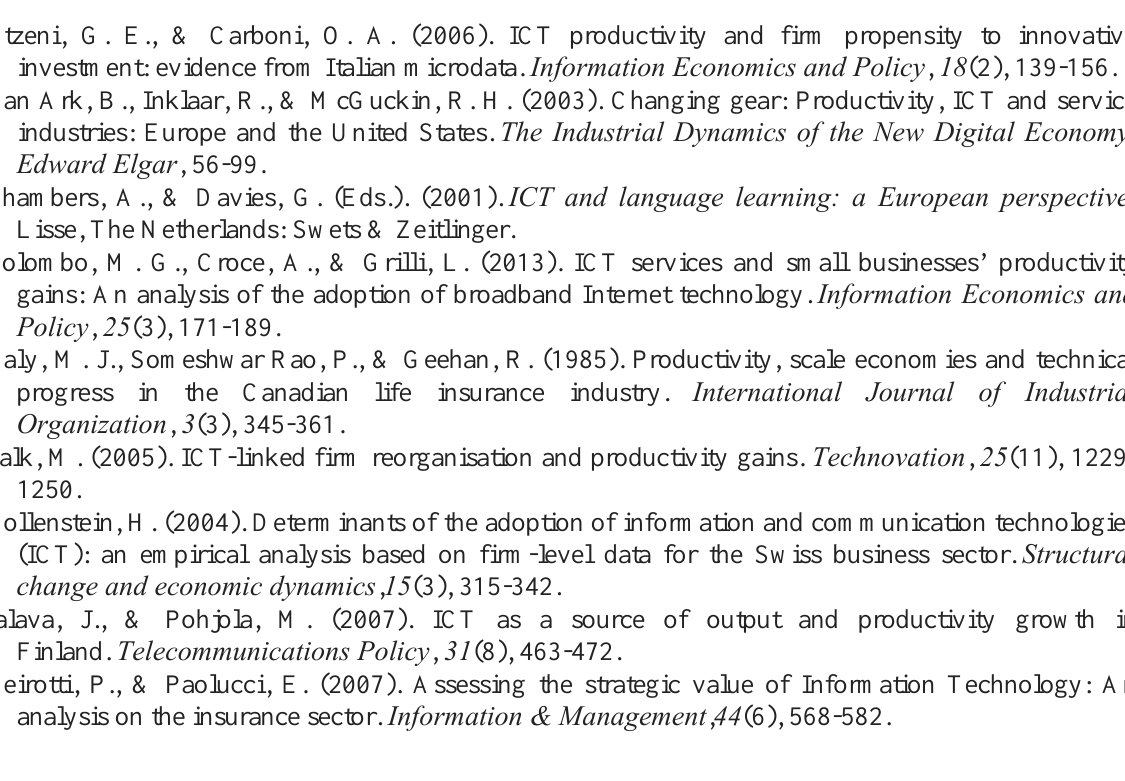
P-value t-value Coefficient